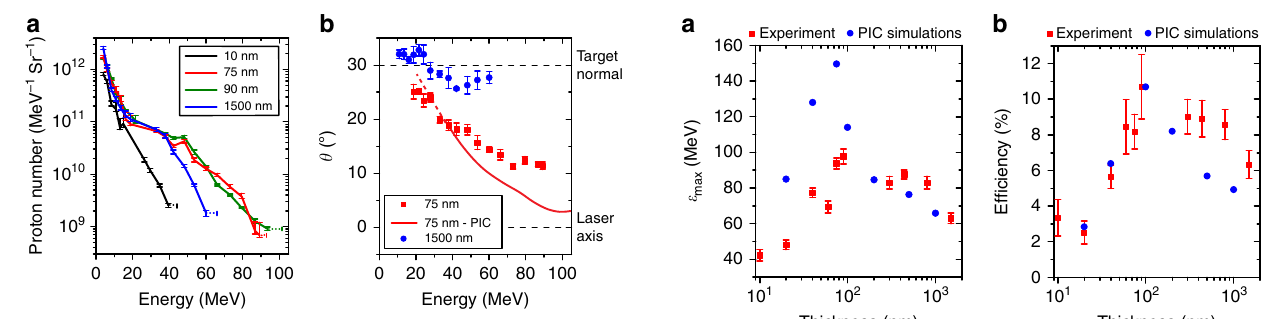
The measured maximum proton energy, ε max , and laser-to- transmission as a function of target areal density, ρ a (to facilitate proton energy conversion ef fi ciency, η , are plotted as a function of comparison of Al and plastic foils), which increases with ‘ in Fig. 3a, b, respectively, alongside results from two- decreasing ‘ . For ‘ < 100 nm, the magnitude of both ε max and η dimensional (2D) PIC simulations (discussed below). In the decrease with increasing transmission. Furthermore, as shown in range ‘ > 170 nm, the results agree with measurements reported Fig. 4b, the recession velocity of the plasma critical density, driven in Wagner et al. 10 , with similar plastic targets and 0.5 – 0.8 ps − 2 by radiation pressure, decreases with increasing transmission, as duration, (0.7 – 2.6) × 10 20 W cm laser pulses. ε max and η are expected. Thus, whereas the results suggest that the measured maximised at an optimum thickness range, ‘ opt ~ 70 – 100 nm. It is enhancement in proton acceleration is concurrent with some in this range that the target undergoes RIT near the peak of the degree of transparency occurring, it is clear that signi fi cant laser intensity. Figure 4a shows the measured degree of laser light